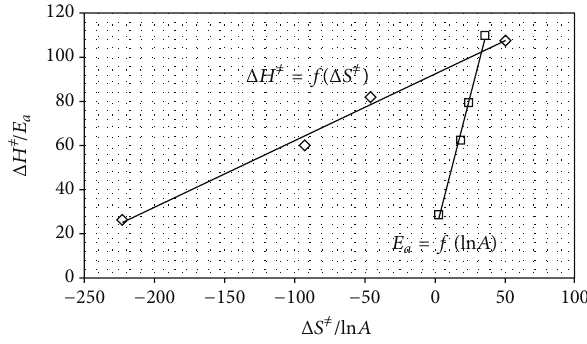
Figure 5: The relationships Δ𝐻 ̸= = 𝑓(Δ𝐻 ̸= ) and 𝐸 𝑎 = 𝑓( ln 𝐴) for the hydrolysis of PPD + catalyzed by hydrogen ions and spontaneous hydrolysis of PPD ± , PPD, and PPD − under the influence of water.